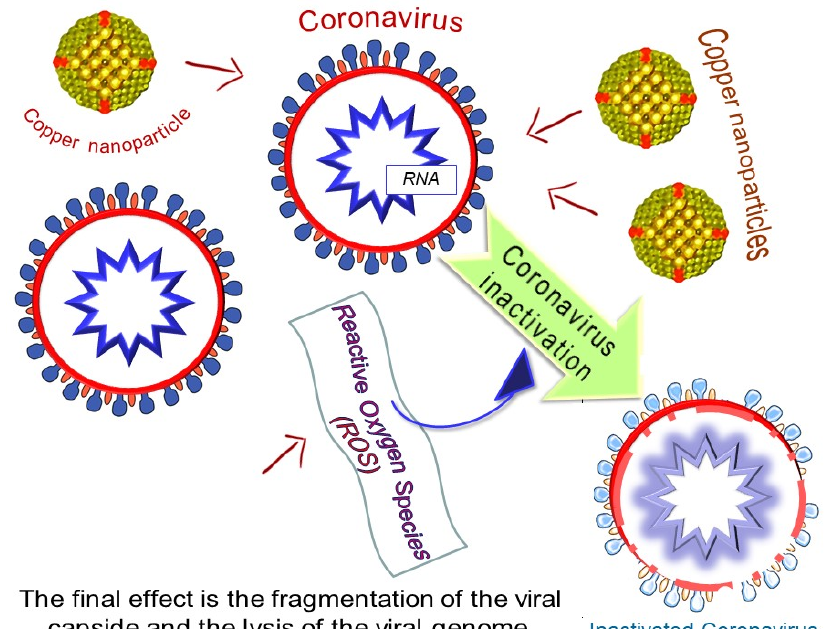
Figure 2. Coronavirus inactivation by copper nanoparticles.